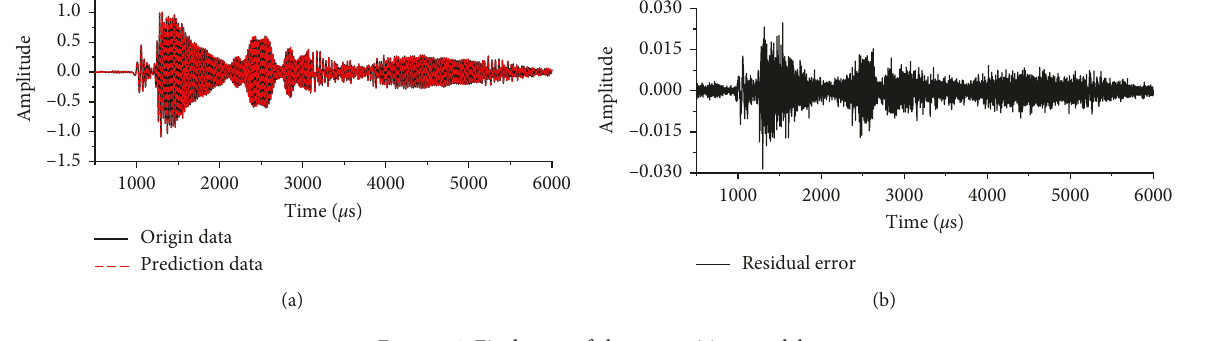
Figure 6: Fit degree of the recognition model.